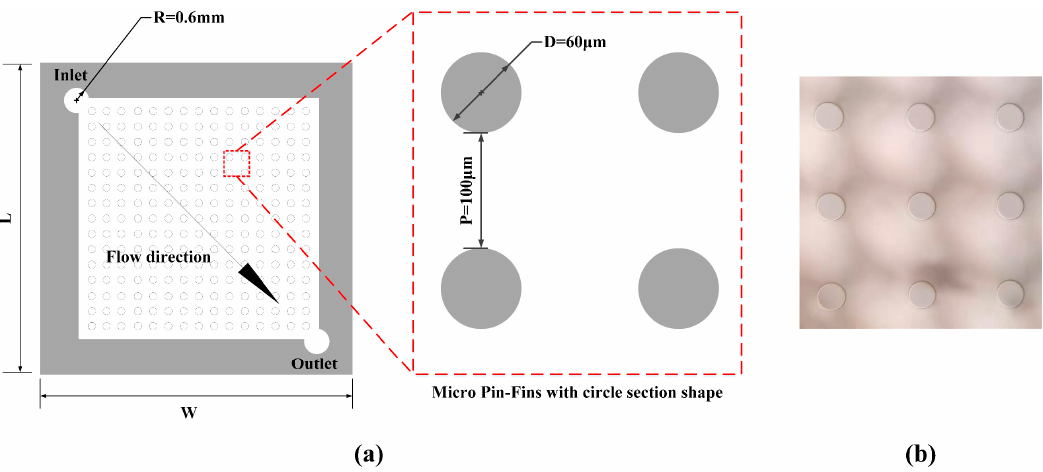
Figure 2. Si-based MPFHS: ( a ) schematic diagram of MPFHS; ( b ) microscopic image of an MPF (micro-pin fins).